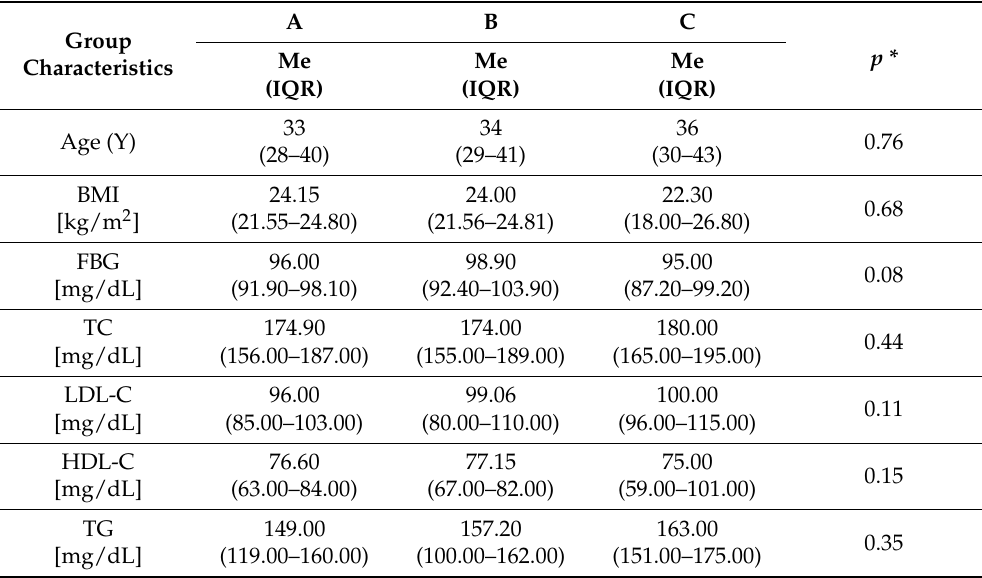
Table 1. Demographic and biochemical data of HIV-infected men before (A) and after cART (B) and the control group (C) with statistical analysis. Group